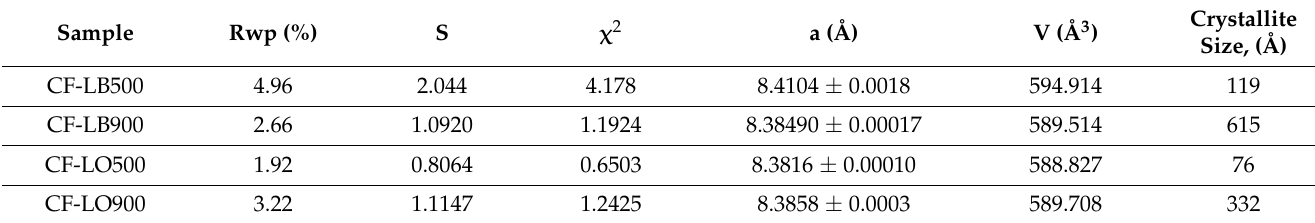
Table 1. Statistical numeric indicators of the wppf (Rwp, S and χ 2 ) and the calculated lattice parameter (a) and unit cell volume ( V